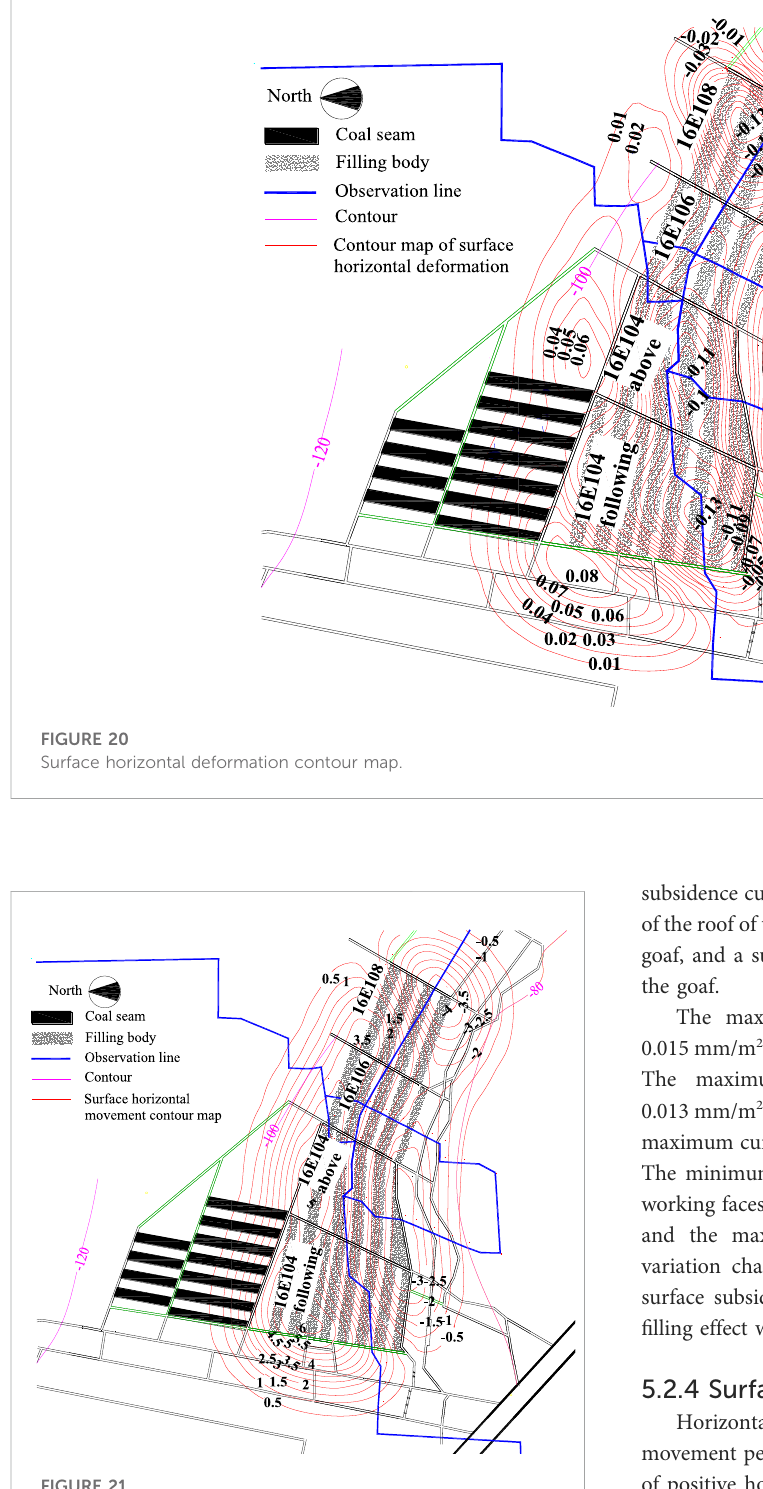
FIGURE 21 Surface horizontal movement contour